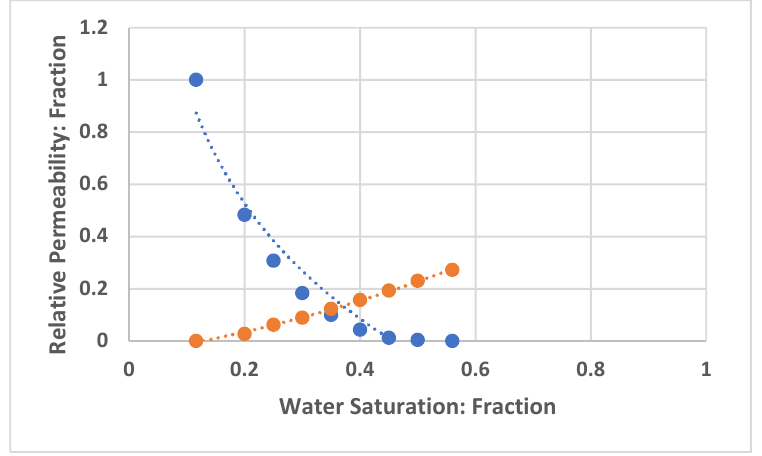
from oil by water.